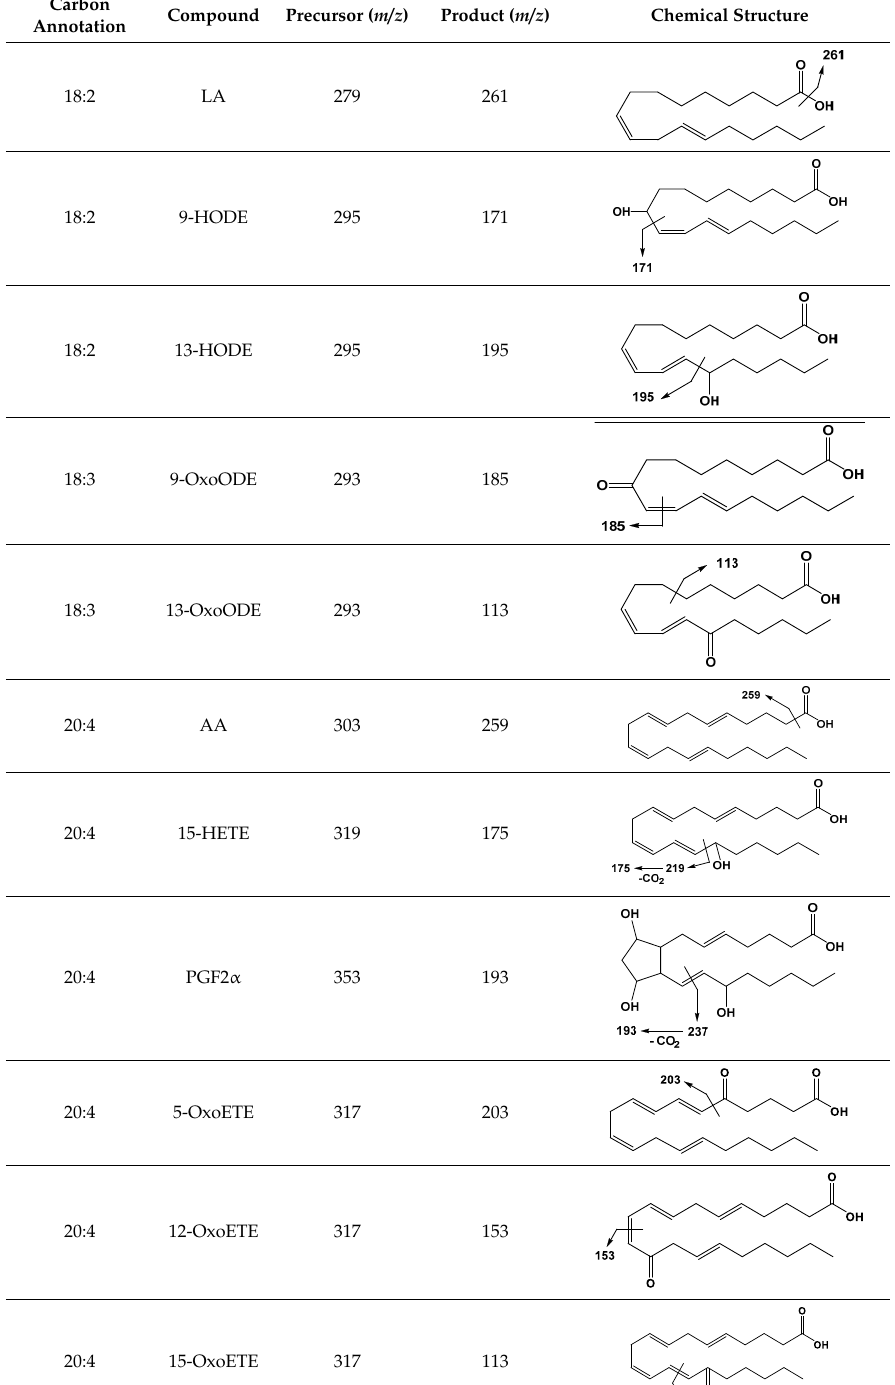
Table 3. Structures of the oxidized polyunsaturated fatty acids with their precursor and their characteristic fragment ion masses. Carbon Annotation Compound Precursor ( m/z )